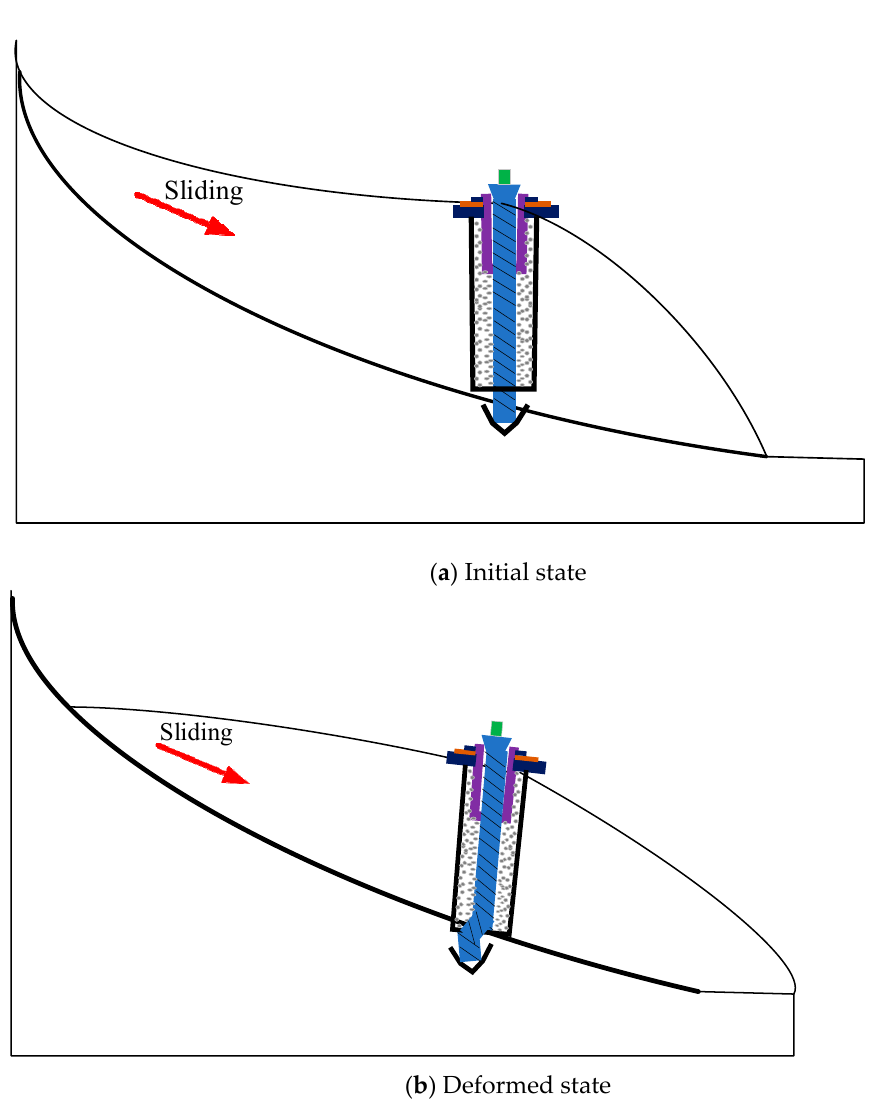
Figure 11. Schematic diagram for the change of flexible device during landslide process.